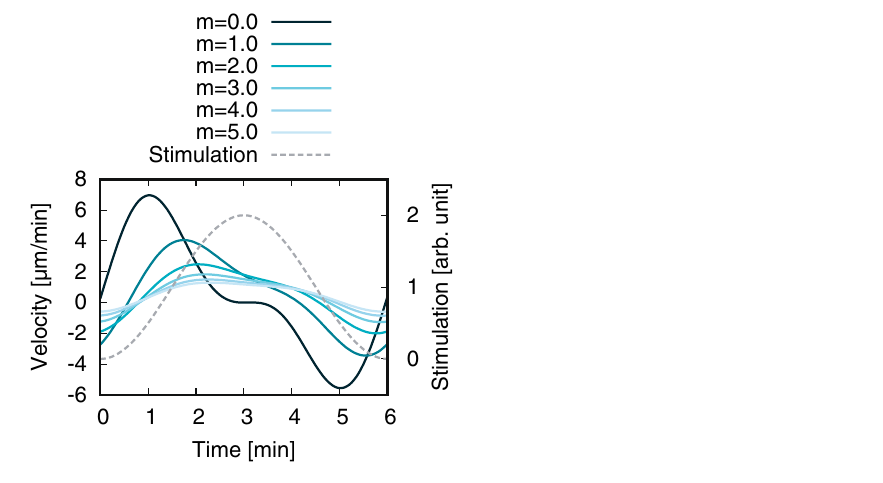
Figure 1. Dependence of the instantaneous velocity, Eq. (6), on the cellular inertia m [ min ] . Other parameters are T = 6 min, α = 0.5 , β = 0.3 min , S 0 = 1.0 S 1 = − 1.0 , γ = 1 , χ 0 = 1000 , and (cid:31) ( = 2 π/ k ) = 1300 µ m